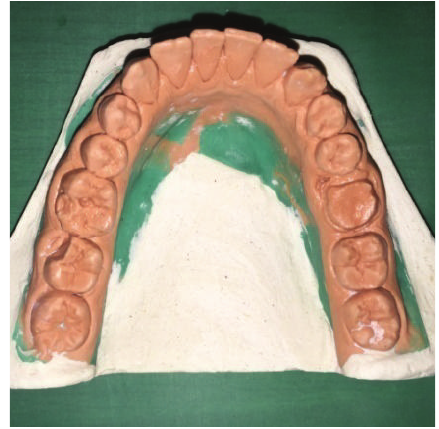
Figure 18: Preoperative cast of tooth 37.